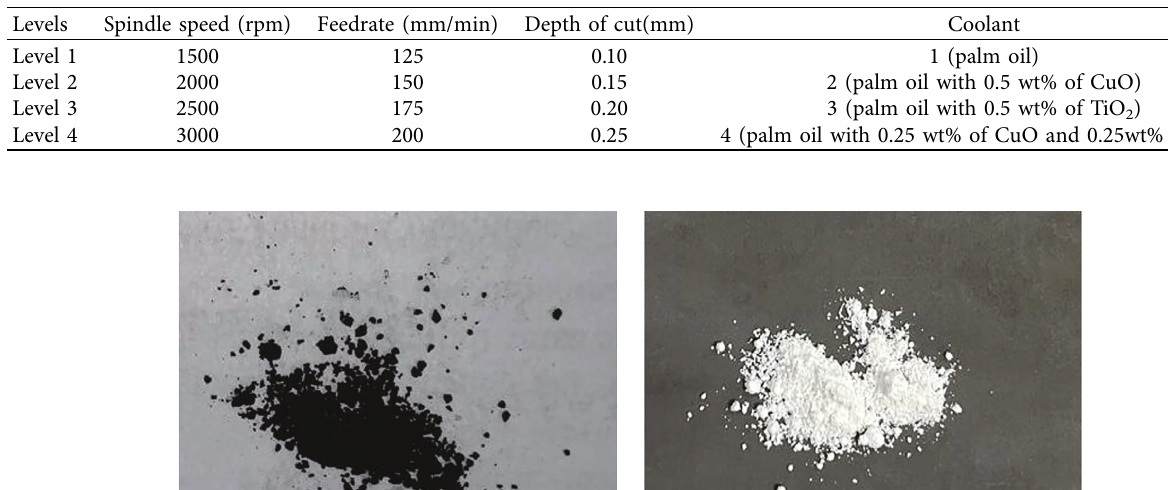
Table 2: Factors and their levels.